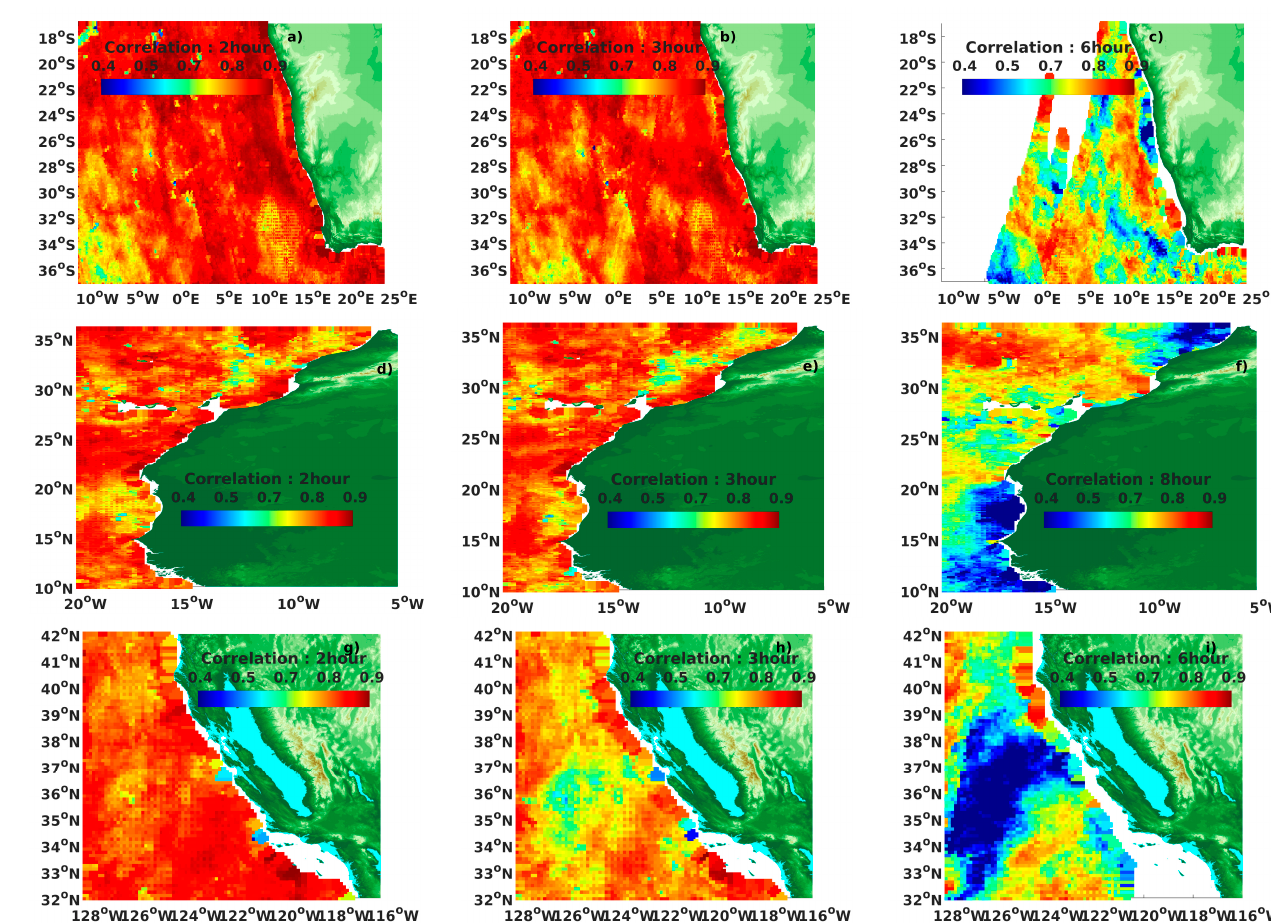
Figure 3. Spatial distribution of lagged temporal correlations of 10 m wind speed ( a , d , g ), zonal wind ( b , e , h ), and meridional wind ( c , f , i ) estimated from homogenized remotely sensed winds [8] in January and July 2000 over Benguela (top), Canary (middle), and California (bottom) upwelling zones. Time lag is included in each panel.